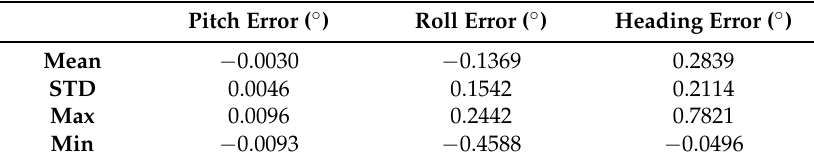
Table 4. Statistical analyses of the attitude errors using the trial